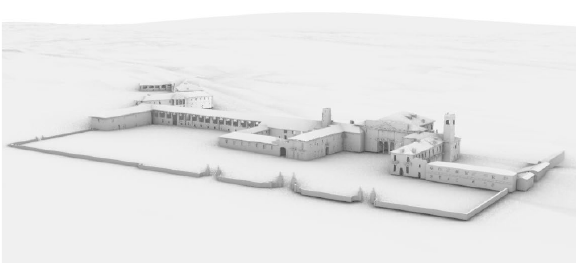
Figure 5 . Figure placement and numbering.